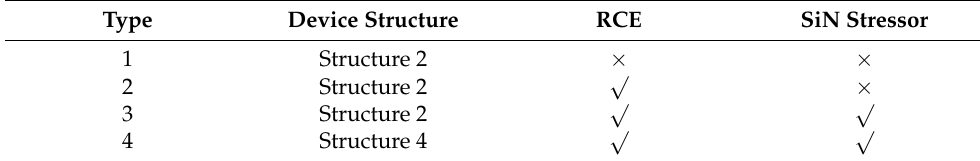
Table 1. Four types of Ge/Si APDs with various structures.